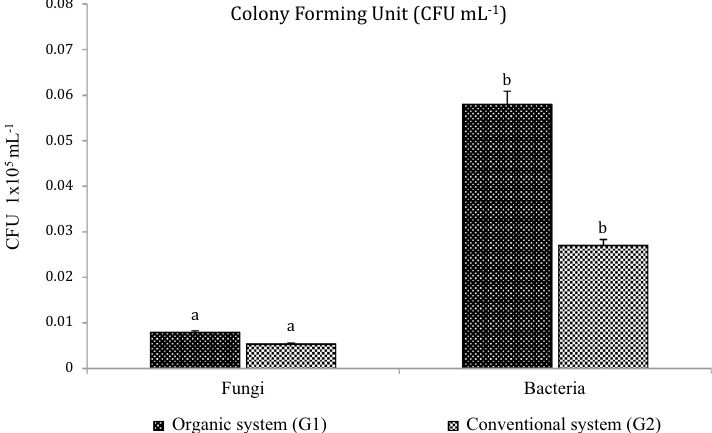
Figure 1. Comparative microbial enumeration of organic and conventional treated mango rhizosphere soil the CFU mL −1 of selected samples showing growth of fungus and bacterial populations under two different treatments i.e. organic and conventional. The results are the average of five replicates (n = 5), with bars representing standard error. Significant differences based on the analysis variance (ANOVA) are shown by different letters above the error bars, followed by the post hoc DMRT test ( p ≤ 0.05) using the software